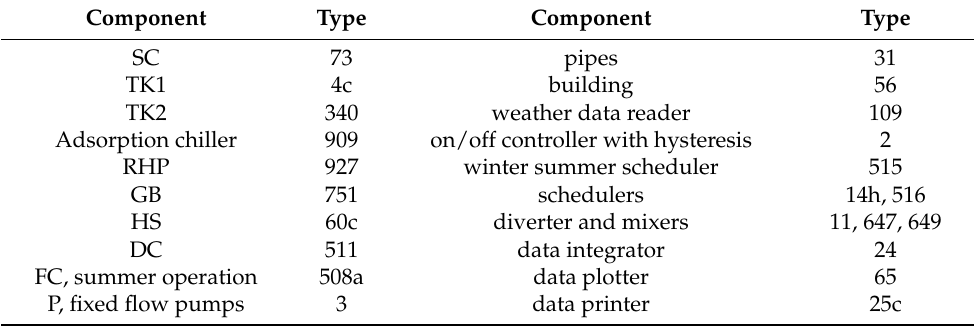
Table 1. TRNSYS components adopted to develop the simulation model of the system. Component Type Component Type SC 73